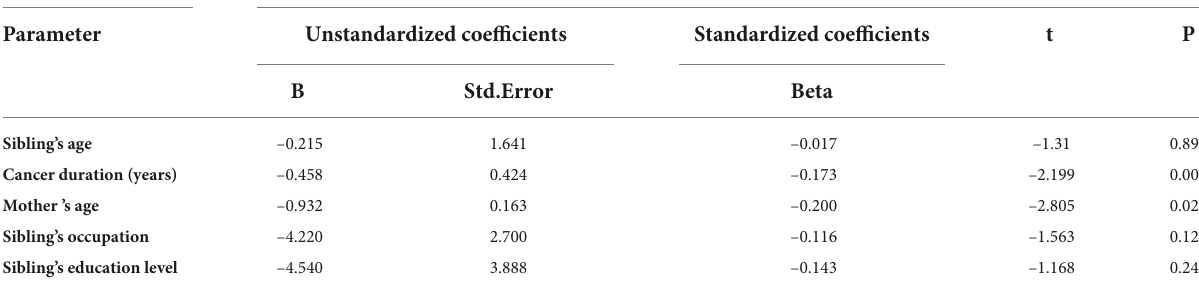
TABLE 5 Results of multiple linear regression analysis between mean summary score of unfulfilled psychosocial needs and demographic and clinical